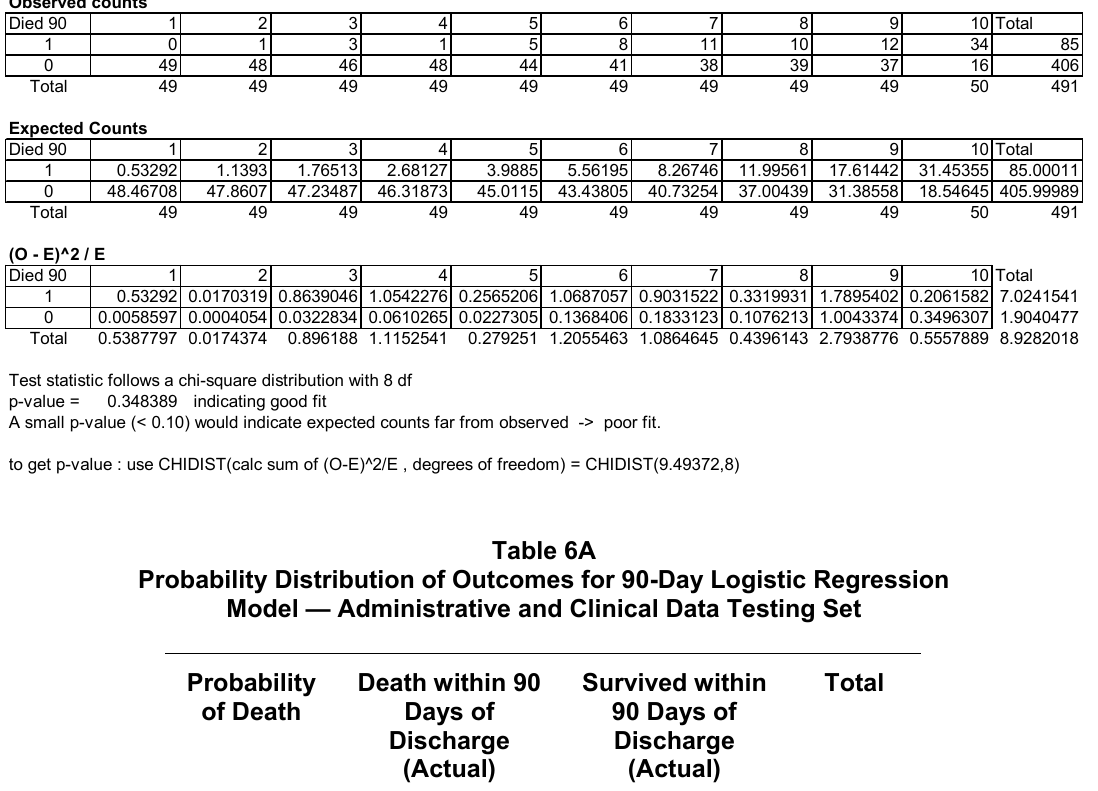
Mortality within 90/365 Days of Discharge Logistic Regression Model. Calculation of Hosmer-Lemeshow Statistic — 90 Days